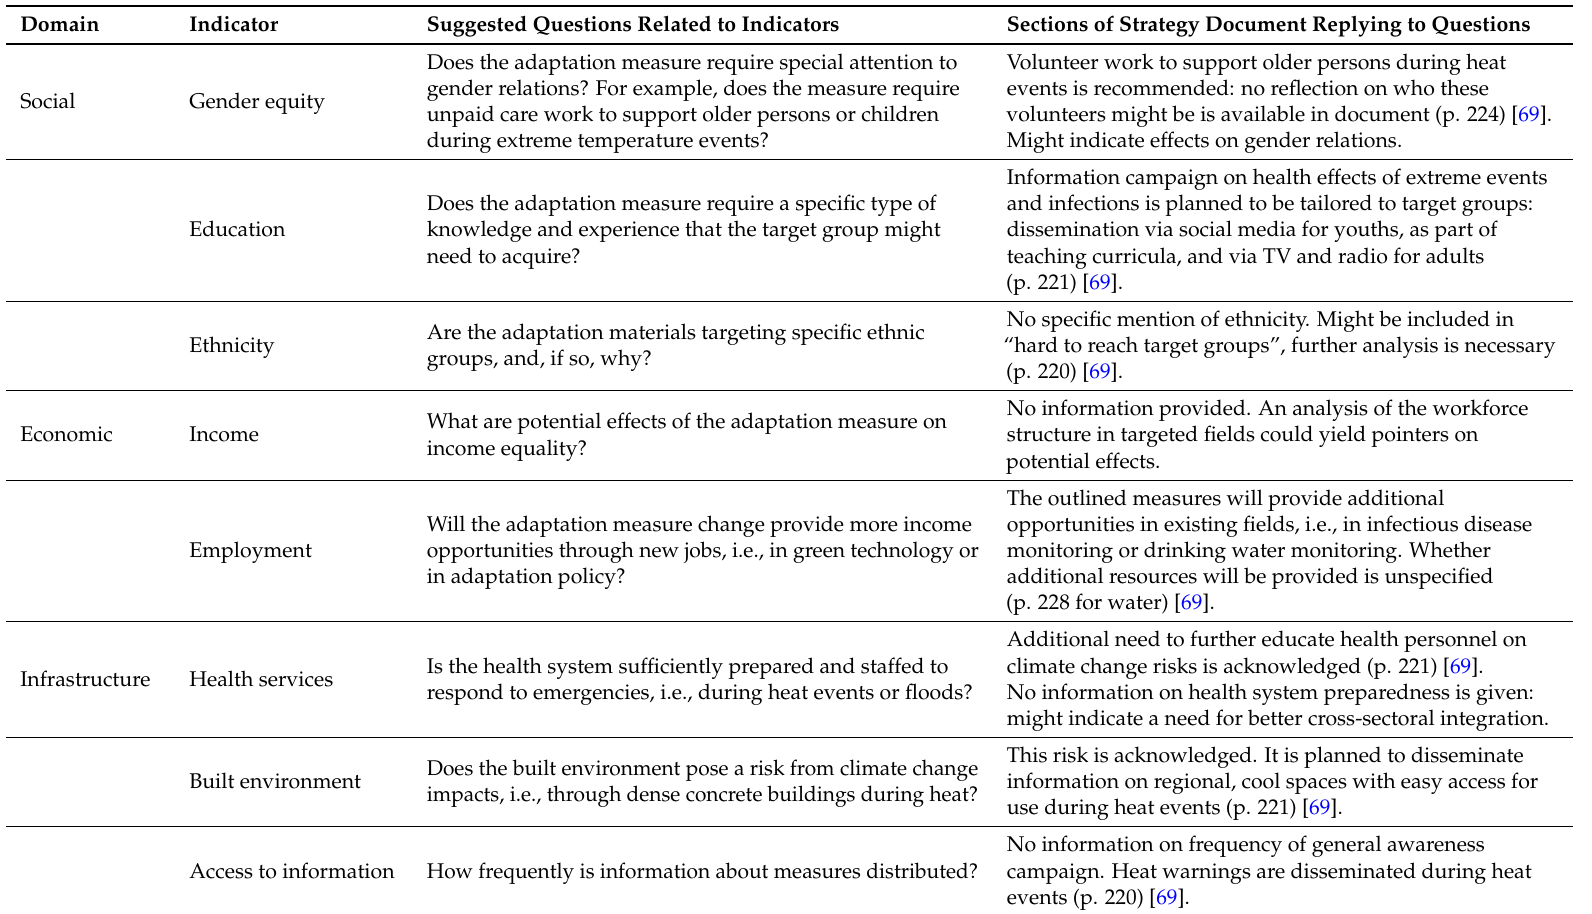
Table 3. An example of using suggested questions to assess a strategy document: The Austrian Adaptation Action Plan